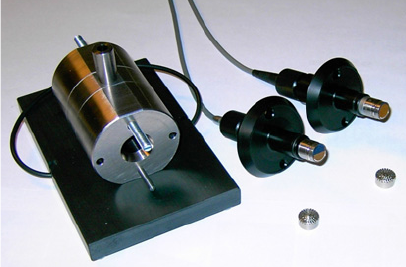
Fig. 17. Wide band coupler for phase comparison calibration of ø 12.7 mm microphones. used for matching of microphones to sound intensity measurements. the coupler fully encloses the microphones in its cavity and works from 20 Hz to 16 kHz. Table 5. Uncertainty of phase comparison calibration of an intensity microphone pair obtained with the B&K phase calibration system and its dedicated couplers. Uncertainty of 20–500